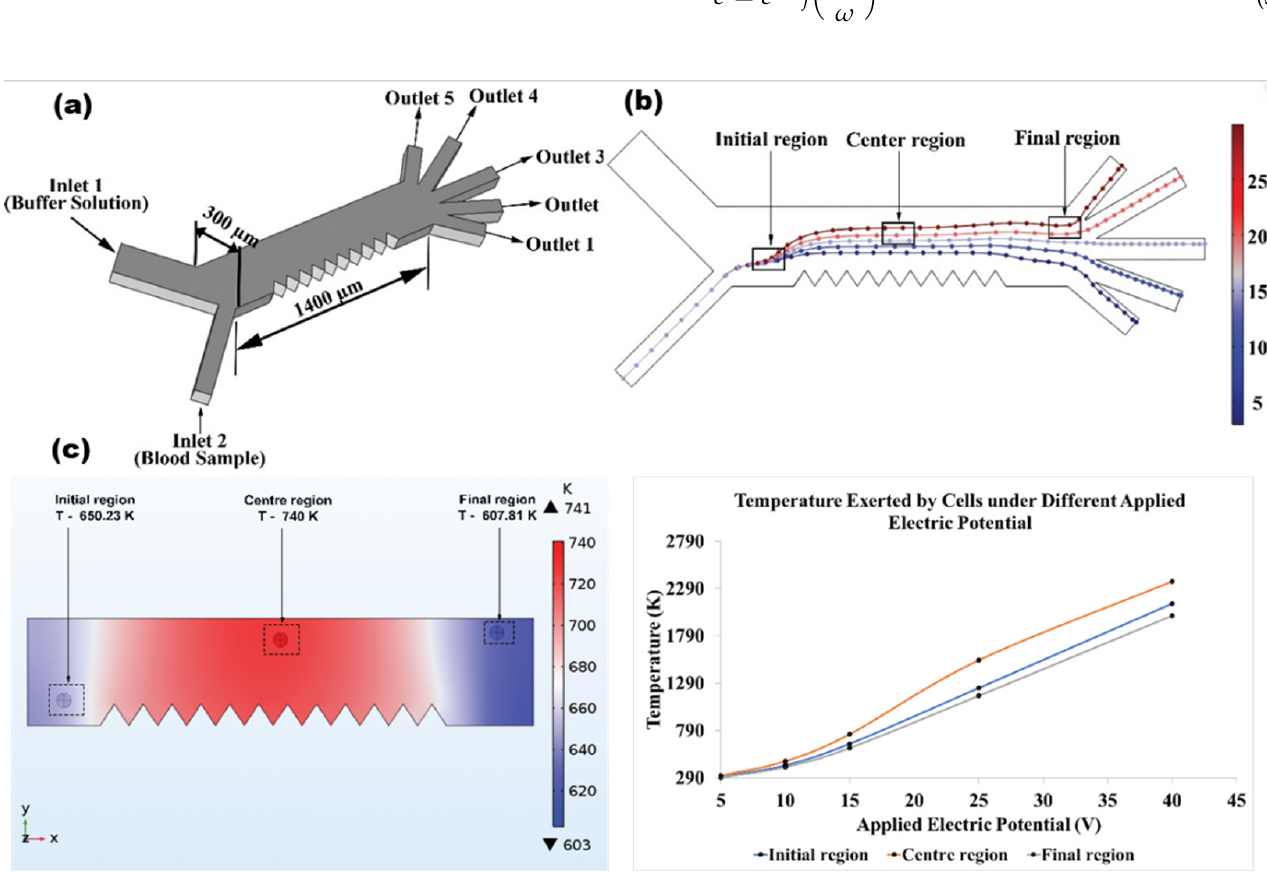
Figure 1. A microfluidic chip design with five outlets arrangements was successfully simulated to separate multiple targets in a single run. ( a ) The schematic illustration of five outlets device showing the dimensions with triangular electrodes arrangements in the side wall. ( b ) Simulation of particle streamlines reveals that cells of distinct sizes (25, 20, 15, 10, 7 µm) were selectively collected in target reservoirs. ( c ) Simulations verify that, strong joule heating was observed in center region of the channel where electric field gradient is very strong.